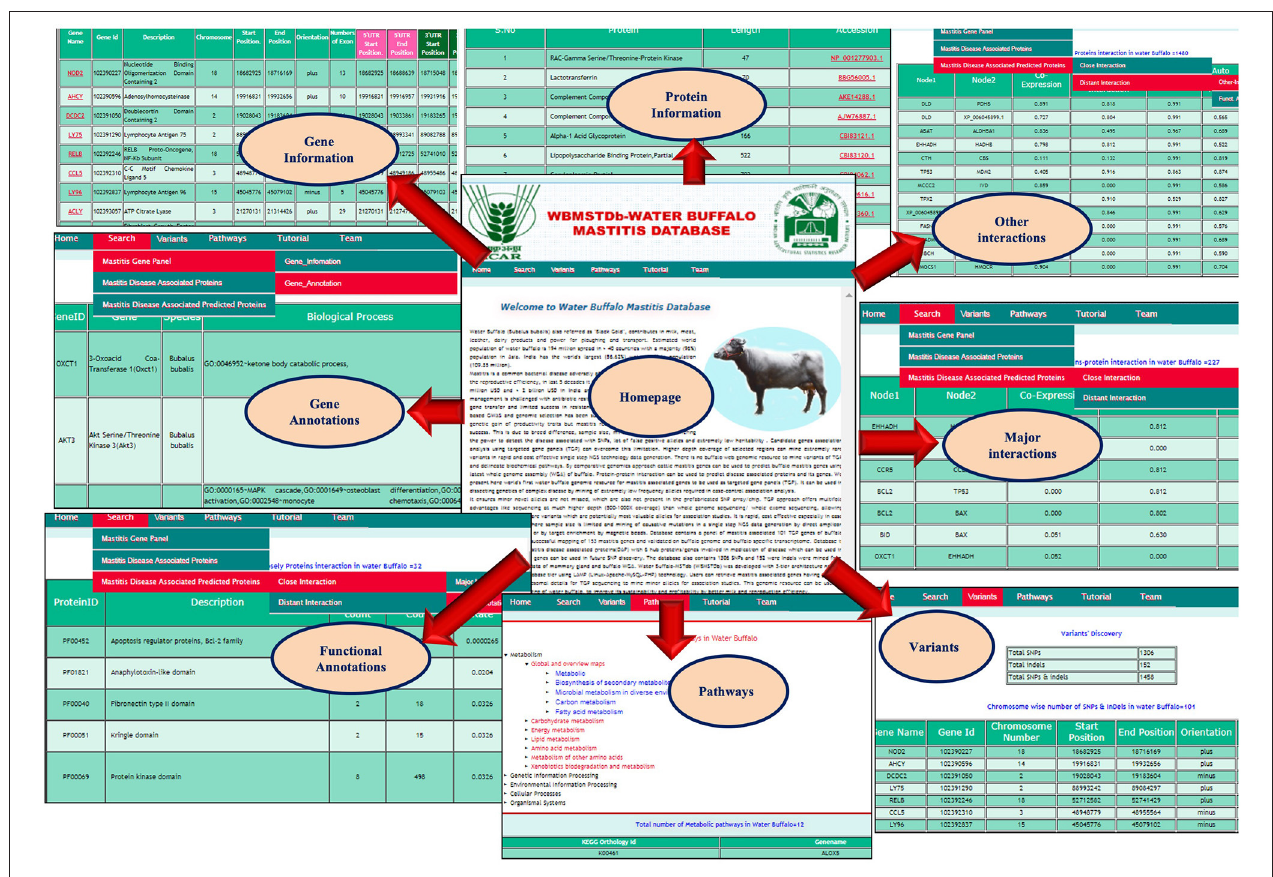
FIGURE 6 | The interface of the WBMSTDb for various type of